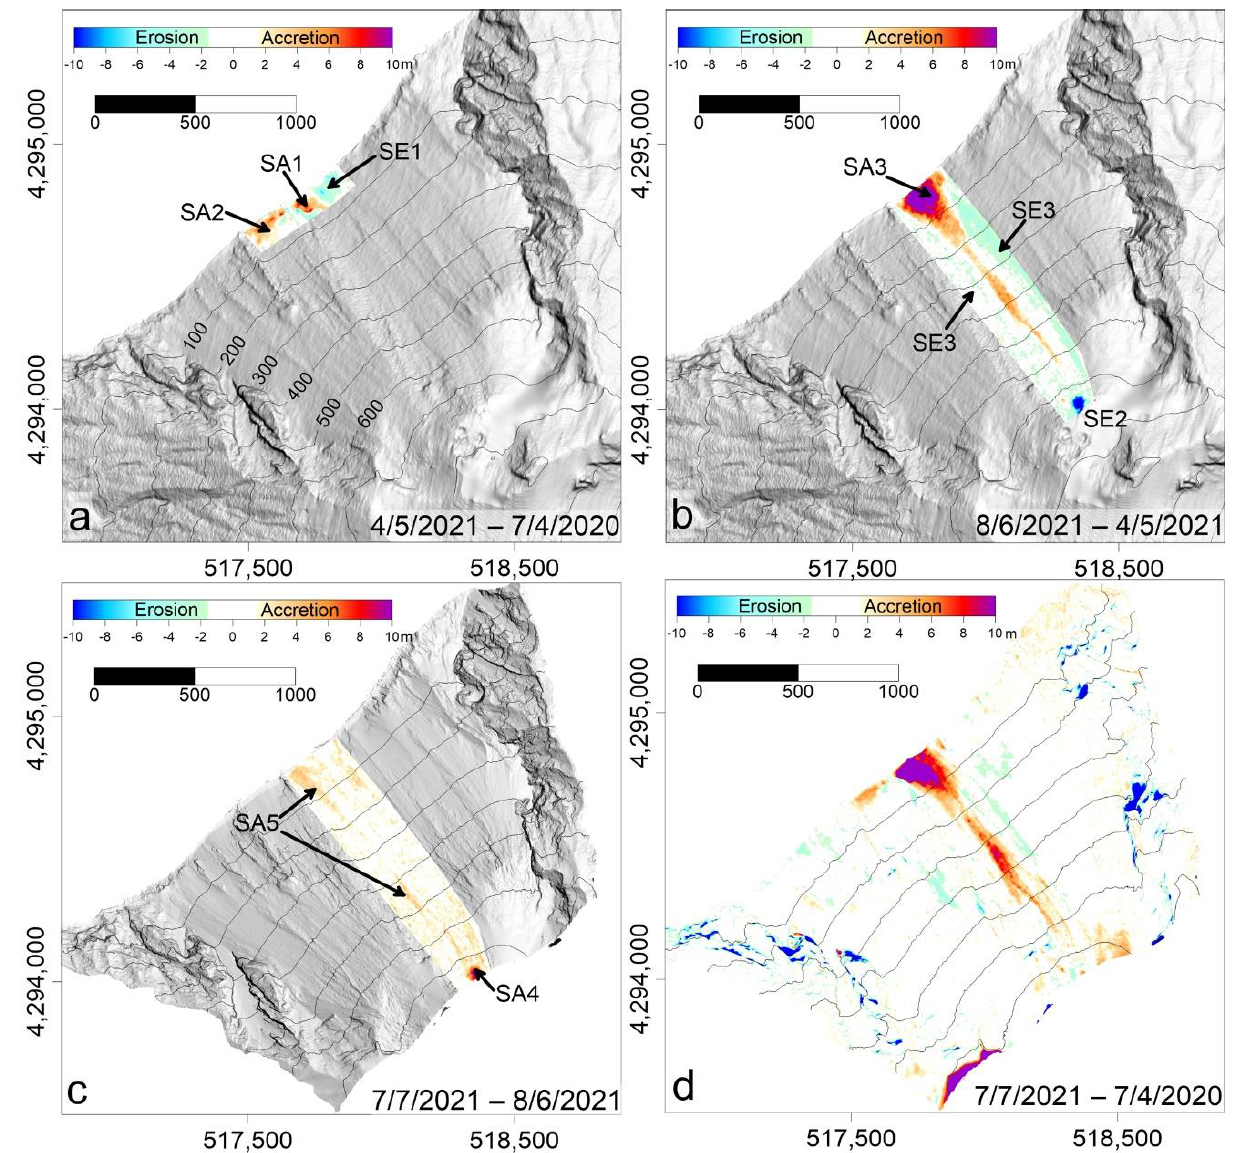
Figure 4. Sciara del Fuoco topographic changes recognized between April 2020 and July 2021 through DEM comparisons; SE and SA stand for subaerial erosion and accretion, respectively. ( a ) May 2021 vs. April 2020 elevation difference map draped over the May 2021 DEM; ( b ) June 2021 vs. May 2021 elevation difference map draped over the June 2021 DEM. The main morphological changes were due to the 19 May 2021 NEC-rim collapse PDC and subsequent lava flows; ( c ) July 2021 vs. June 2021 elevation difference map draped over the July 2021 DEM; ( d ) July 2021 vs. April 2020 comparison shows the morphological changes of the subaerial SdF during the complete investigation period. The frames ( a – c ) were cleaned for the residual mismatching between DEMs after the co-registration. Frame ( d ) was not cleaned to show the distribution and the magnitude of the residual mismatching between the first and the last DEMs.